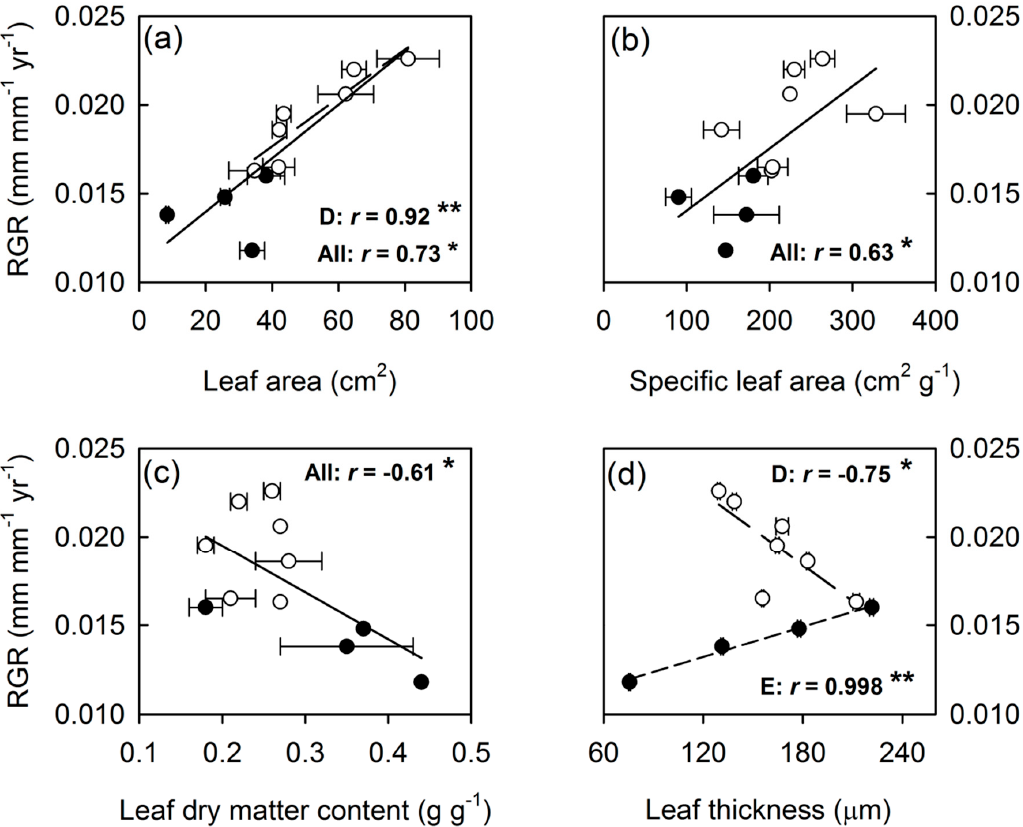
Figure 3. Relationships of relative growth rate (RGR) values with ( a ) leaf area, ( b ) specific leaf area, ( c ) leaf dry matter content, and ( d ) leaf thickness across seven deciduous (D, open circle, long dashed line) and four evergreen (E, filled circle, short dashed line) lianas. Solid lines indicate significant correlations between RGR and leaf traits across 11 liana species. The horizontal error bars indicate the standard error of leaf traits. Note: * p < 0.05; ** p < 0.01.